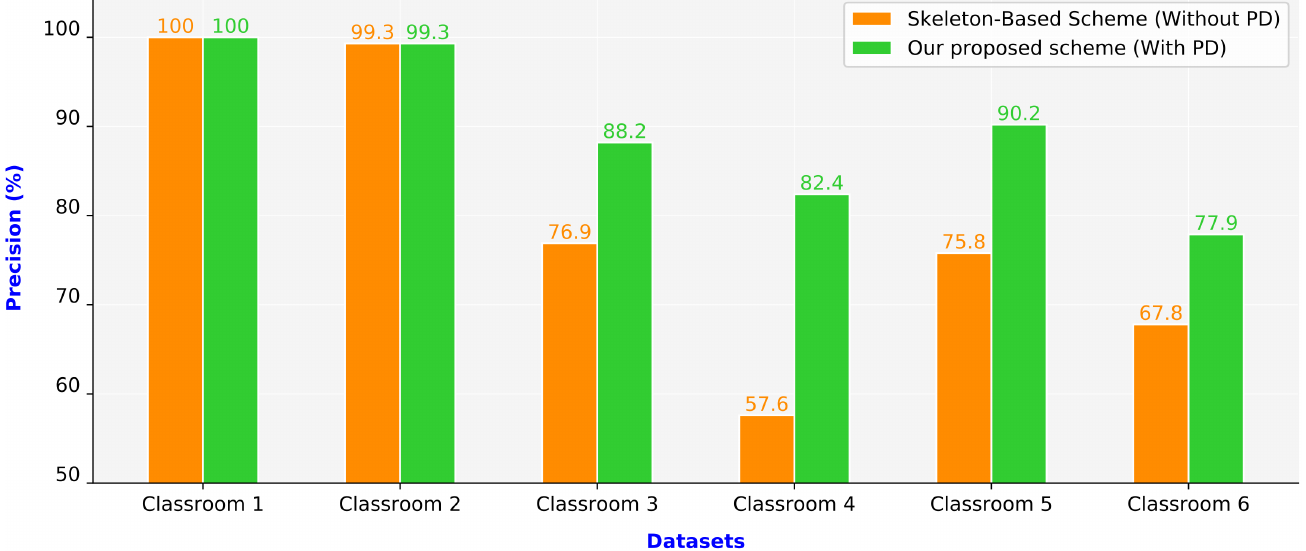
Figure 11. Precision values of the schemes (PD: person detection).